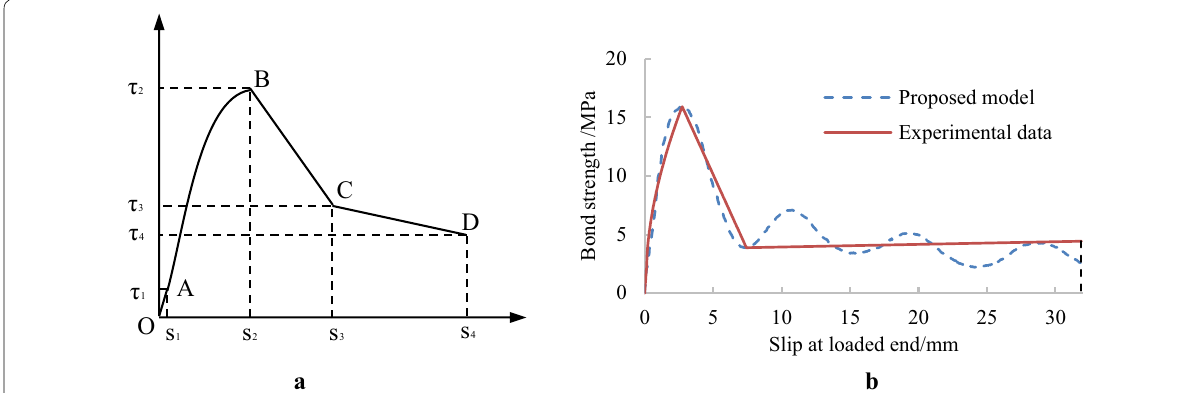
Fig. 13 a Bond–slip constitutive law for BFRP bar in concrete and b comparison of proposed model and experimental data during the whole slip process.